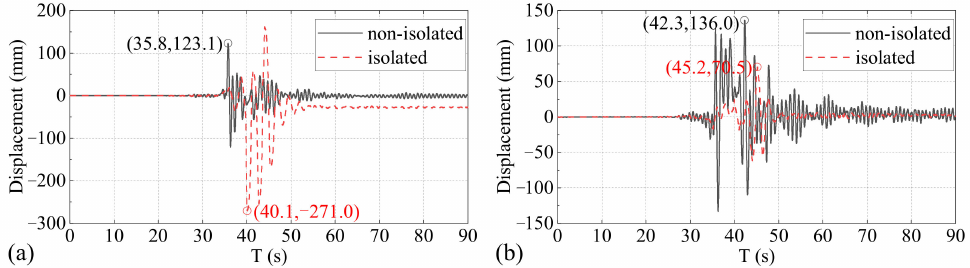
Figure 11. The displacement time histories of pier P2. ( a ) X-direction. ( b ) Z-direction.